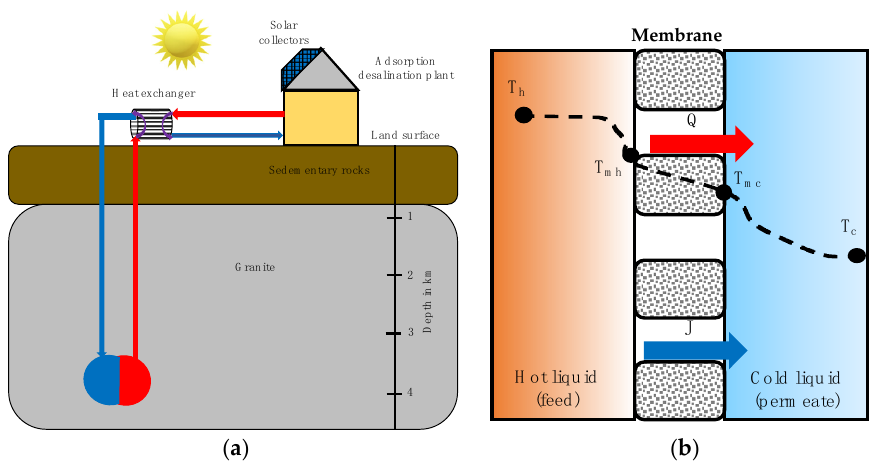
Figure 6. ( a ) Combined-cycle geothermal and solar-powered desalination. The system is powered by solar energy during daylight hours and by geothermal energy during nighttime and cloudy days. ( b ) Principle of direct contact membrane distillation process. Based on Ghaffour et al. [81].